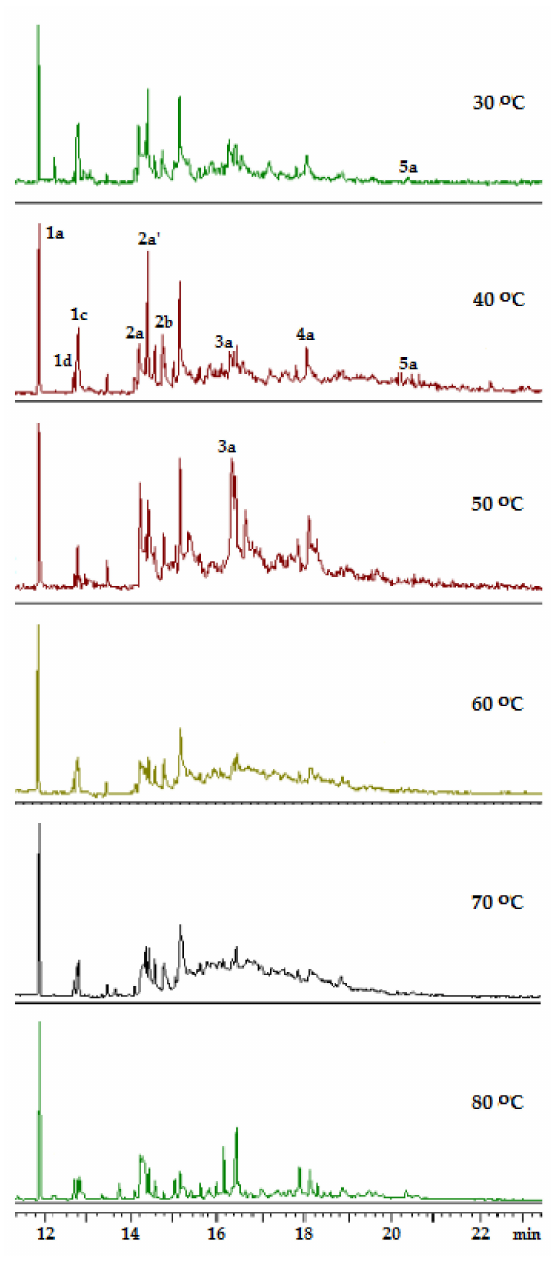
Figure 4. Chromatograms of diethyl ether extracts of reaction mixtures containing oxidation products of 0 obtained by slow drip addition of a 50% aqueous solution of H 2 O 2